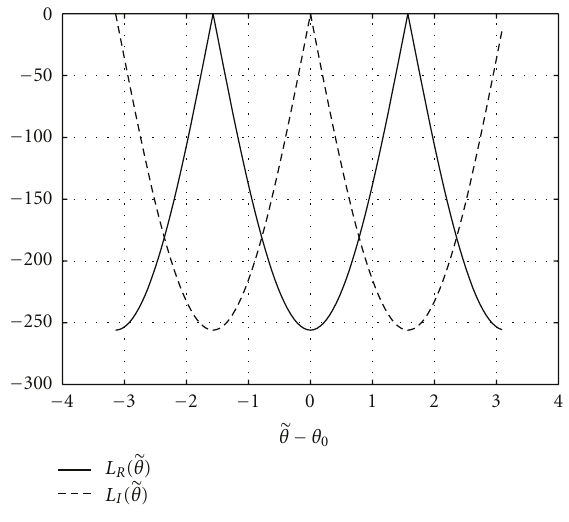
Figure 1: L R ( (cid:2) θ ) and L I ( (cid:2) θ ) versus the phase o ff set estimation error ( (cid:2) θ − θ 0